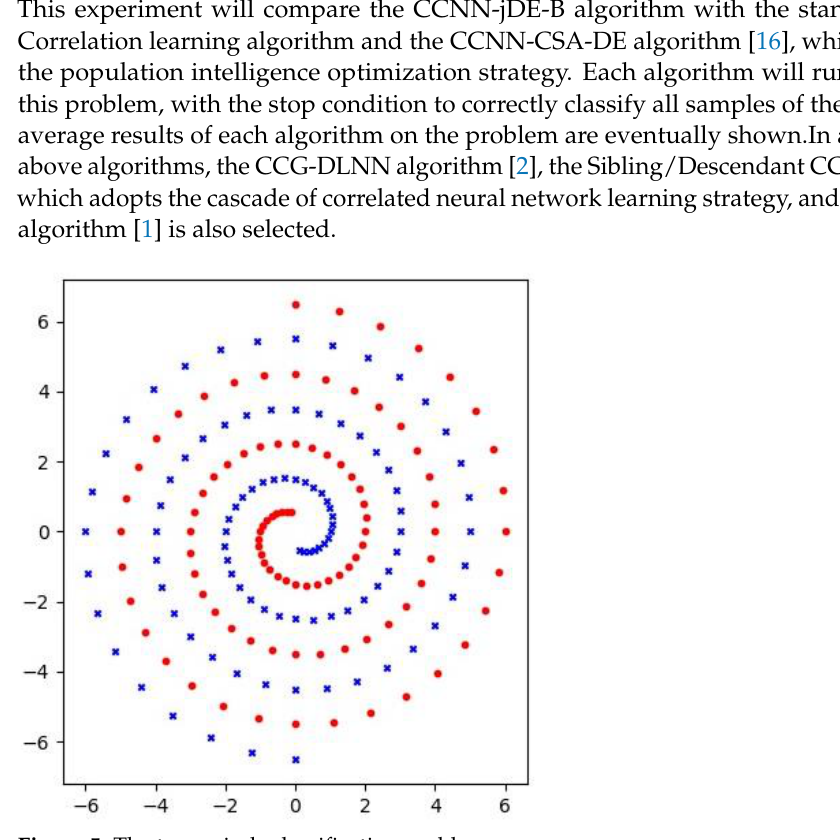
Figure 5. The two spirals classification problem.